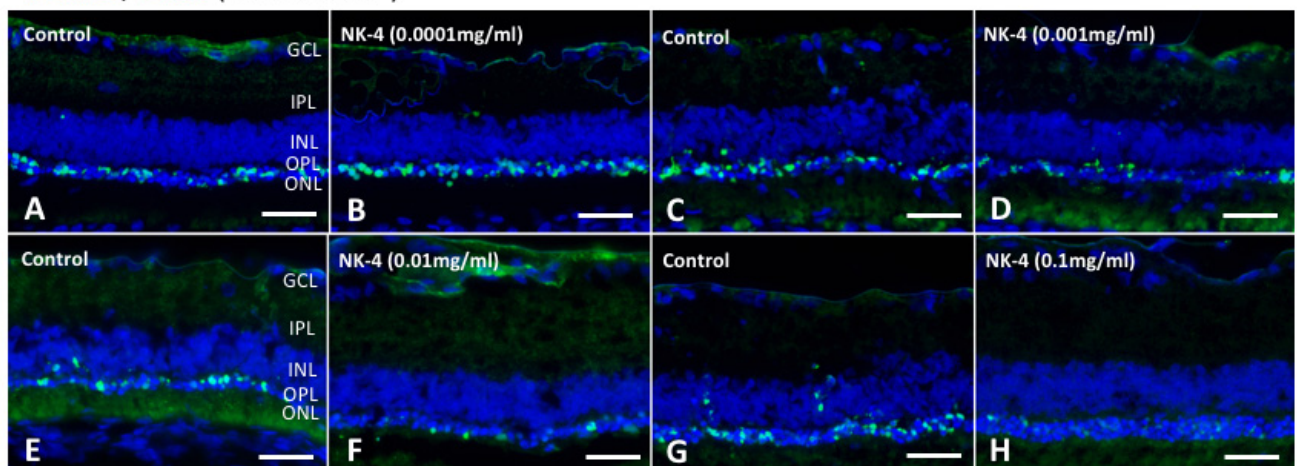
Figure 2. TUNEL staining of retinal sections at the site of “f”. TUNEL assay indicated that TUNEL-positive signals (green) were mainly detected in the ONL and were likely to be fewer in retinas treated with NK-4 (0.0001 mg/mL, 0.001 mg/mL, 0.01 mg/mL, and 0.1 mg/mL) than in those with control vehicle. Cell nuclei were counterstained with DAPI (blue). Pair groups: ( A ) vs. ( B ), ( C ) vs. ( D ), ( E ) vs. ( F ), ( G ) vs. ( H ). ONL, outer nuclear layer; INL, inner nuclear layer; OPL, outer plexiform layer. Scale bar = 25 μ m.